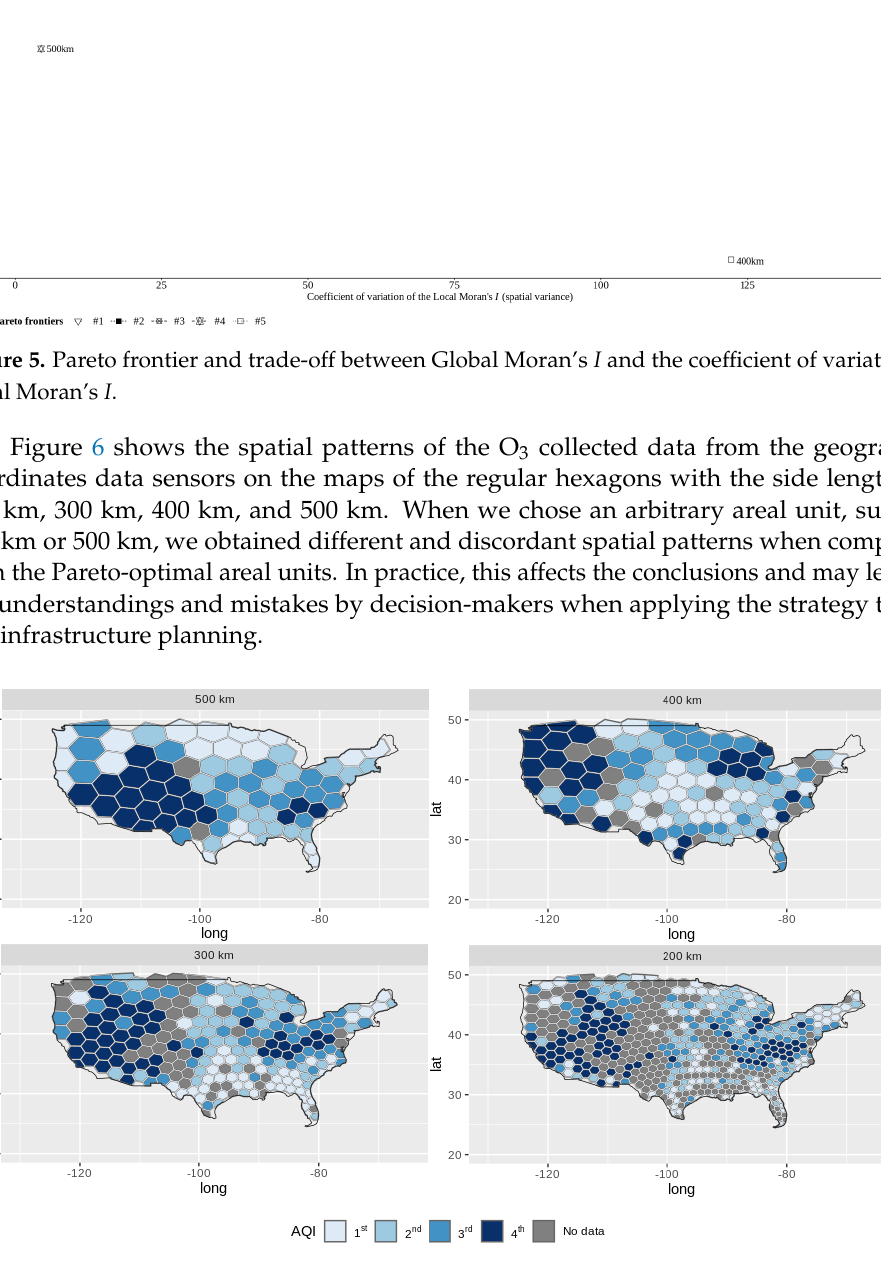
Figure 6. Comparison of spatial patterns of Pareto-optimal areal units with others arbitrary areal units. The patterns correspond to the ‘odds ratio measure’ of the frequency of geographic coordinates’ O 3 data